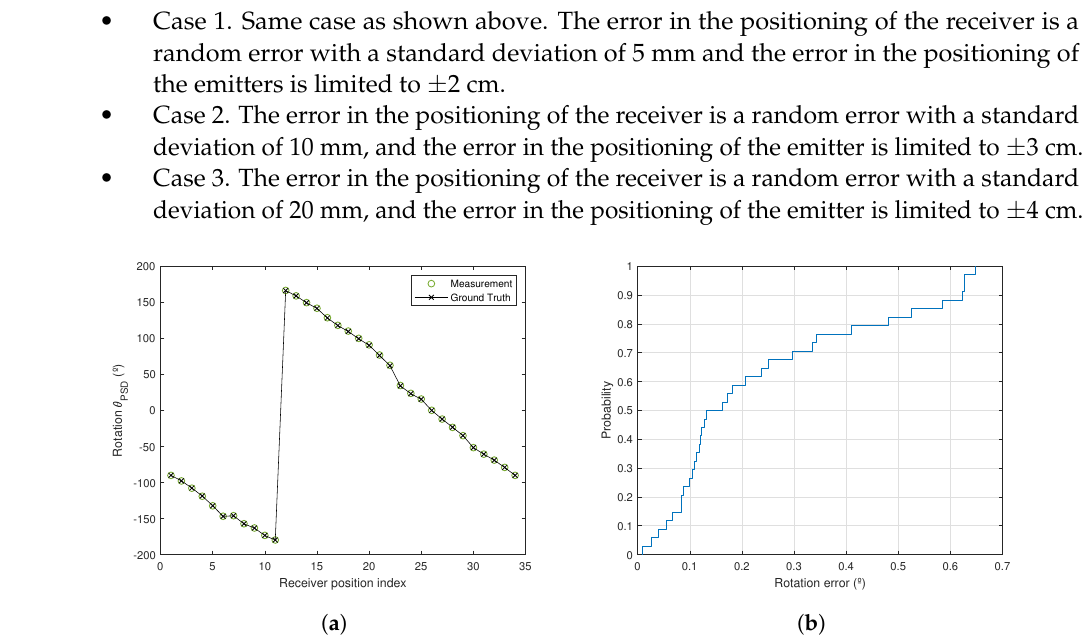
Figure 9. Rotation angle results using emitters 1 and 4. ( a ) Calculation of the rotation angle; ( b ) CDF of the rotation error. Table 5. Mean error of the 44 receiver positions using calculated and known height in the three test cases. Error Using Calculated Height (mm)